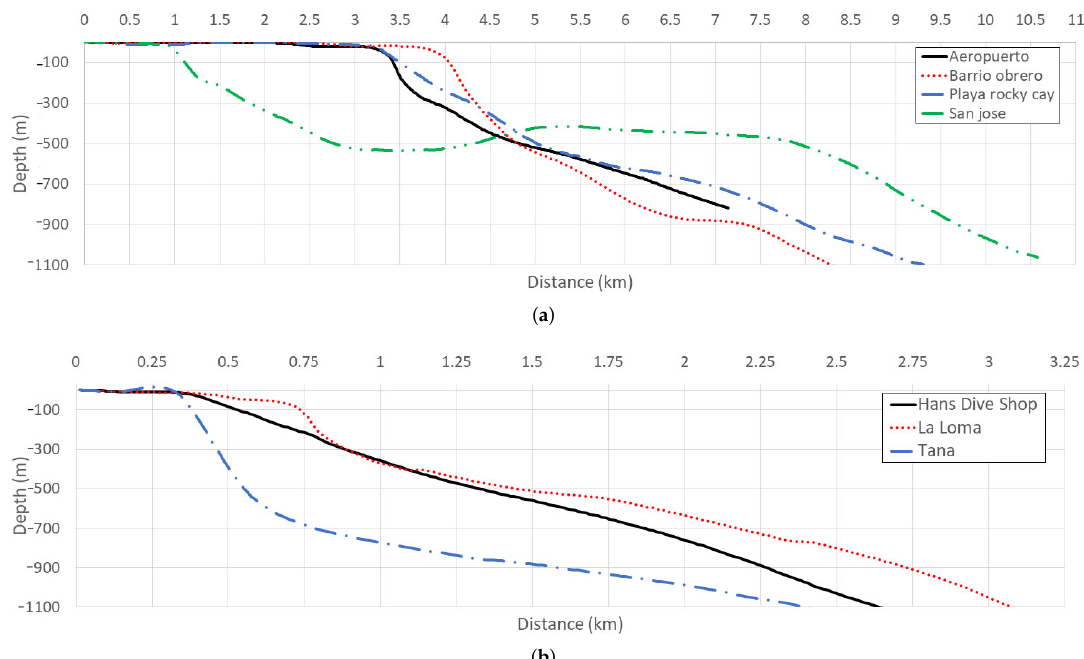
Figure 9. Profiles in 7 points of San Andrés. ( a ) SIZ1 and ( b )